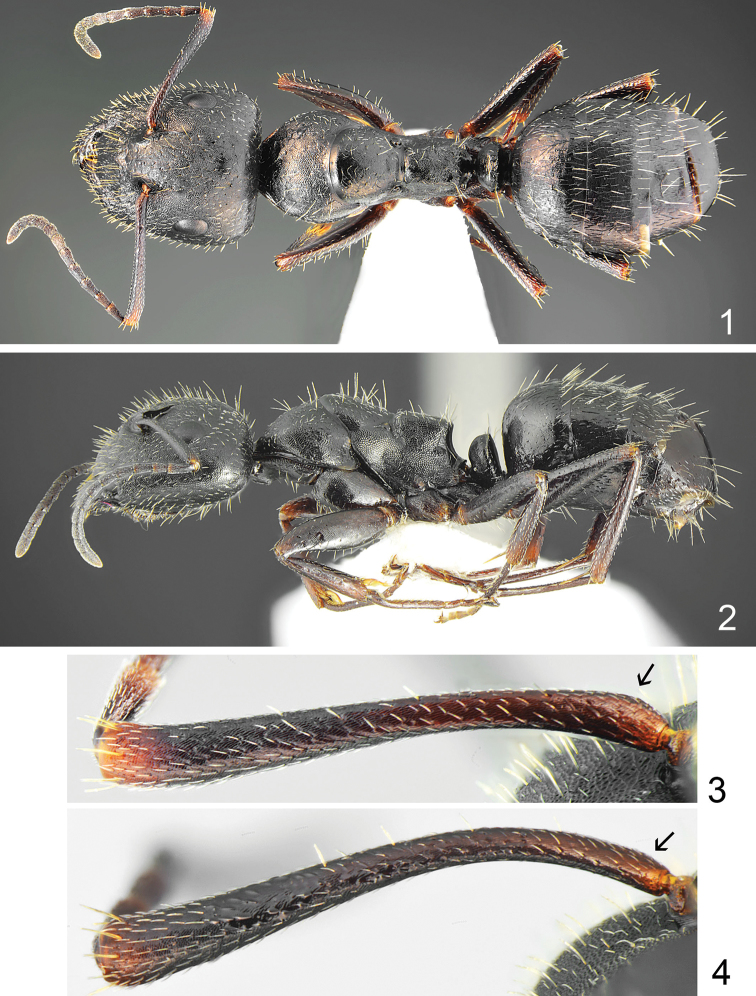
1, 2Camponotus
schulzi sp. nov., major worker: 1 dorsal 2 lateral 3, 4 antennal scape 3Camponotus
schulzi sp. nov. 4Camponotus
nitidescens (arrows indicate the base of scape lacking extension).